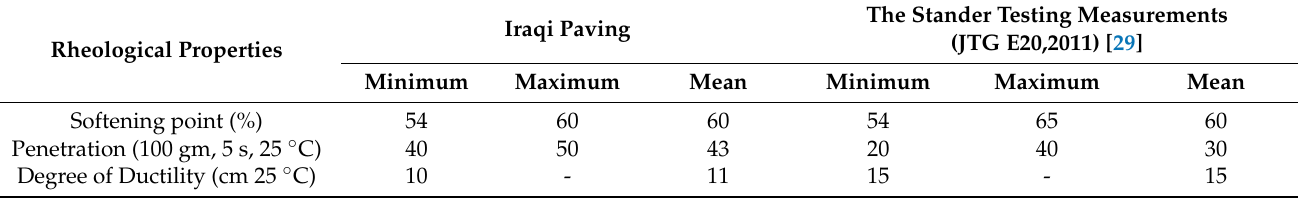
Table 2. Rheological properties of Iraqi paving asphalt vs. the standard testing measurements (JTG E20,2011).